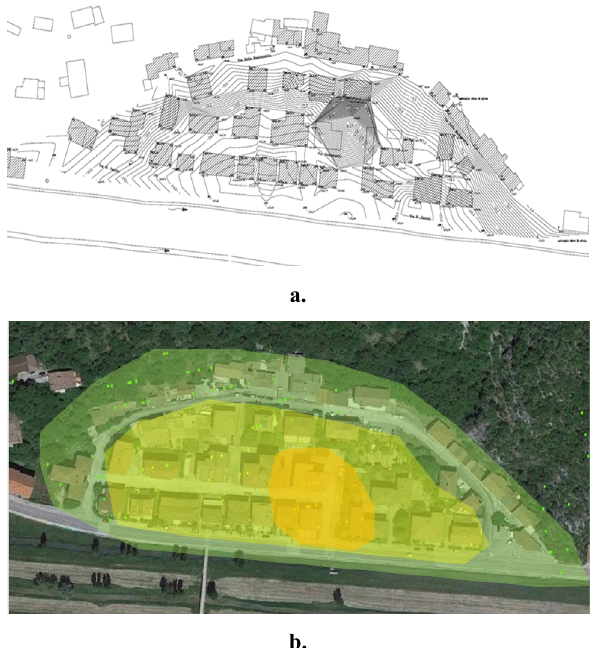
Figure 10. a. Map of the subsidence curves generated from the analysis of topographic levelling data. b. Heat map of the terrain subsidence from the elaboration of DInSAR data.